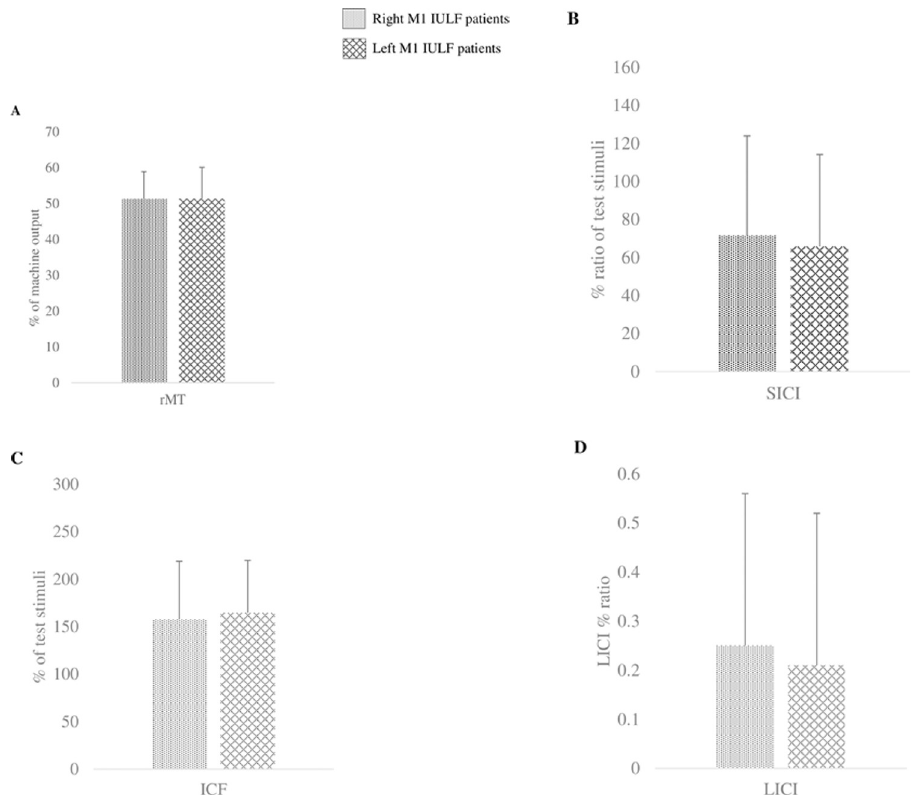
Fig 2. Between IULF-group differences on TMS measures stratified according to the stimulated hemisphere. A. Between IULF-group differences on rMT stratified according to the stimulated hemisphere. B. Between IULF-group differences on SICI stratified according to the stimulated hemisphere. C. Between IULF-group differences on ICF stratified according to the stimulated hemisphere. D. Between IULF-group differences on LICI stratified according to the stimulated